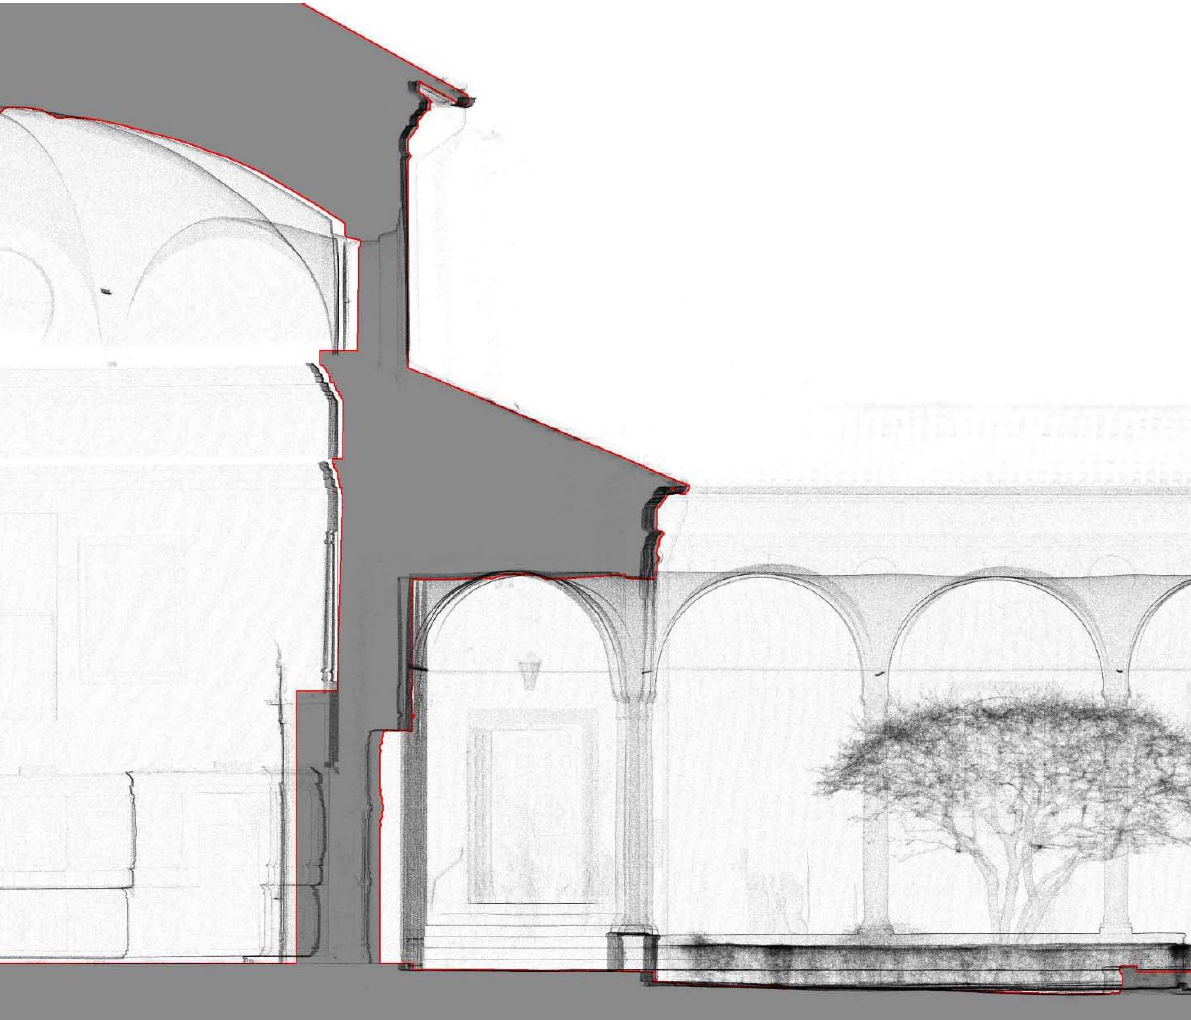
Figure 9. A detail of the longitudinal section at 1:100